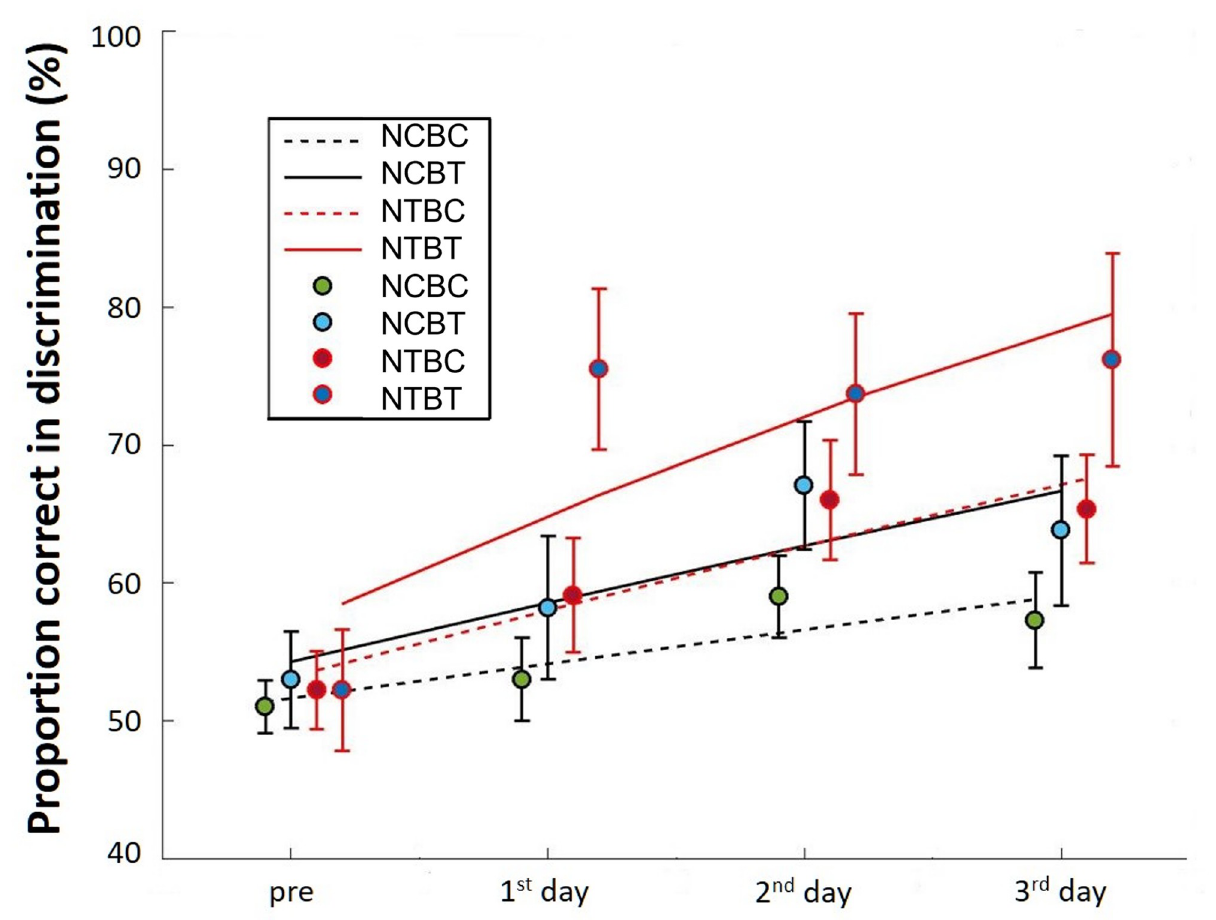
Fig 5. Performance in the BAD test. Average proportion of correct responses and logit models for pre-training test and post-training test data for the NCBC group (black dashed line), NCBT group (black solid line), NTBC group (red dashed line), and NTBT group (red solid line) in the discrimination test on each training day for two sounds. Error bars represent the standard error of the mean (SEM).